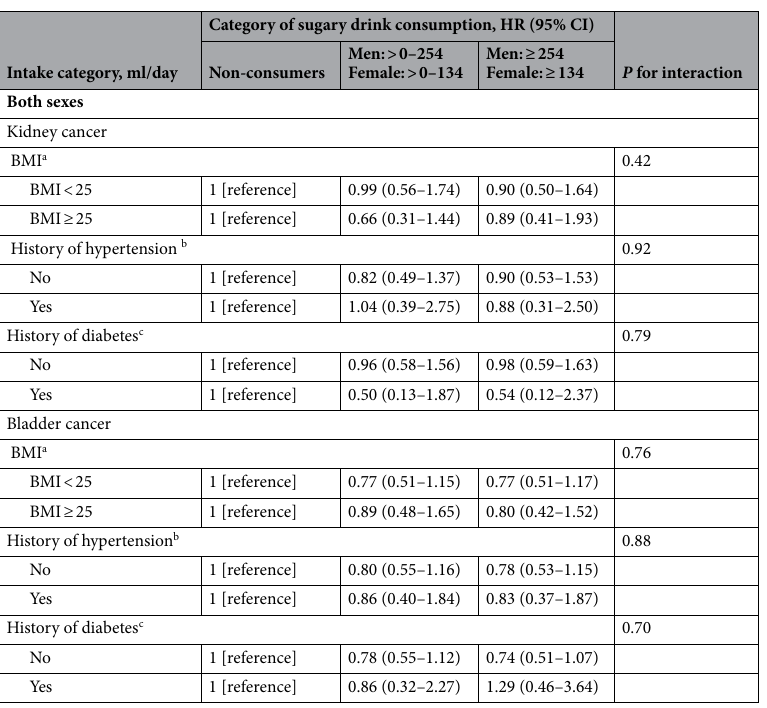
Table 2. Hazards for kidney and bladder cancer incidence according to intake of sugary drinks in Japanese men and women. HR hazard ratio, CI confidence interval, No. number. a Minimally adjusted model adjusted for age (year); public health center (10 areas); smoking status and intensity (never; former; current: < 20 cigarettes per day; current: ≥ 20 cigarettes per day); physical activities (metabolic equivalent task, hours per day, tercile); and intake of total energy (kcal per day) (continuous). b Multivariable Cox regression model adjusted for age (year); public health center (10 areas); body mass index (< 18.5, 18.5 to < 25, 25 to < 30, or 30 to < 45); history of hypertension (yes or no); history of diabetes (yes or no), smoking status and intensity (never; former; current: < 20 cigarettes per day; current: ≥ 20 cigarettes per day); consumption of alcohol (ethanol gram per week), coffee (gram per day), fruit (g per day, tercile), vegetables (g per day, tercile), biscuits (g per day, tercile), cake (g per day, tercile), chocolate (g per day, tercile), and Japanese-style confectionery (g per day, tercile); physical activities (metabolic equivalent task, hours per day, tercile); height (cm, tercile); and intake of total energy (kcal per day) (all continuous). c History of hypertension, history of diabetes, and body mass index were not adjusted for. Sugary drinks included beta-carotene-fortified beverages, calcium-fortified beverages, canned coffee, carbonated beverages, 100% fruit juices (apple juice and orange juice), lactic acid bacteria beverages, and vitamin-fortified beverages.